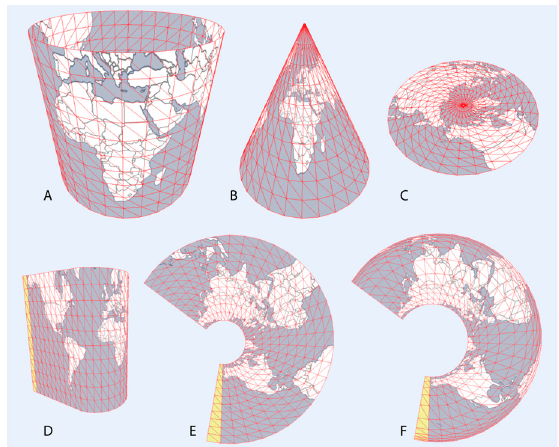
Figure 4. Different ways of how the mesh is modified to represent different states of the projection surface: ( A ) a cylinder; ( B ) a cone; ( C ) a plane (disc); ( D ) an intermediate state during a flattening process; ( E ) a flattened cone; ( F ) a scaled flattened cone. The reference stripe is indicated in yellow. For readability, a mesh with a low resolution is depicted (30 radial and 10 vertical segments). To reduce graphical artefacts, a mesh with a higher resolution is recommended (e.g., 100 radial and 50 vertical segments).